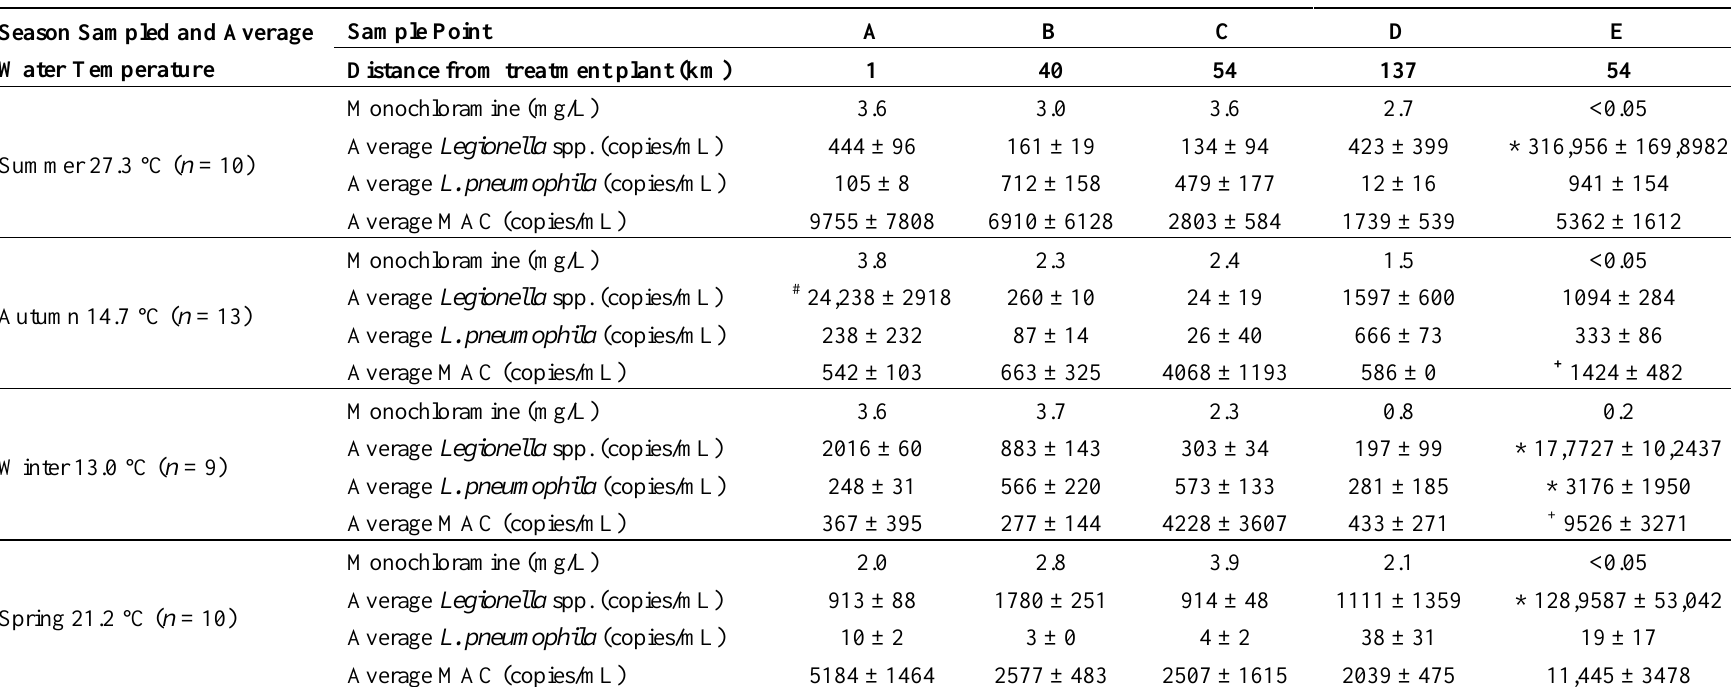
Table 2. Average concentration of Legionella spp. L. pneumophila and MAC (mean ± standard deviation copies/mL) measured at each sampling point of Distribution system 2 (DS2) using qPCR. Total monochloramine (mg/L) measured when samples were collected is also shown as well as the average water temperature for the month during which the sample was taken. The sampling points where a significant increase ( p < 0.05) in the concentration of an organism compared to the concentration measured at sample point A within the same sampling period are also highlighted